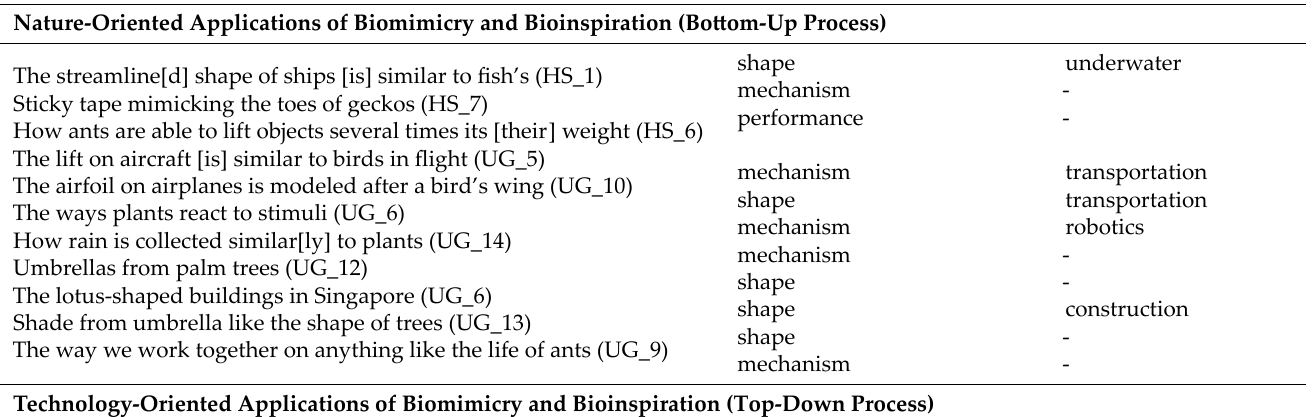
Table 4. Answers to Question 1 are classified into “nature‑oriented” and “technology‑oriented” groups. The bioinspiration trait column relates to the kind of biomimicry involved, and the field of application relates to the area in which the proposition could be applied. The tick marks indicate that the answer did not provide the bioinspiration trait or application